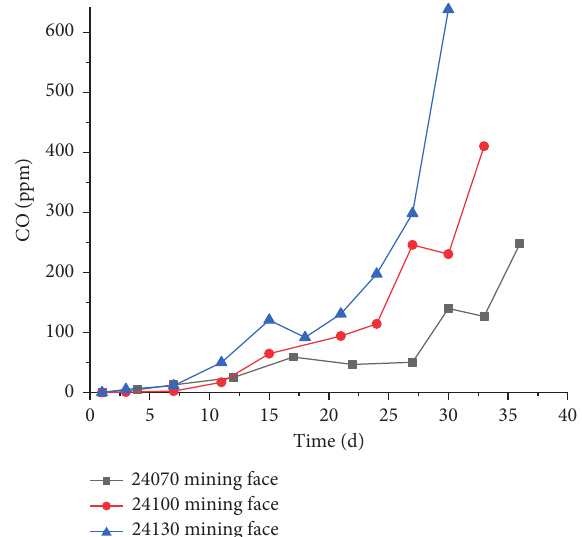
Figure 1: Variation in CO concentration with time in the different mining